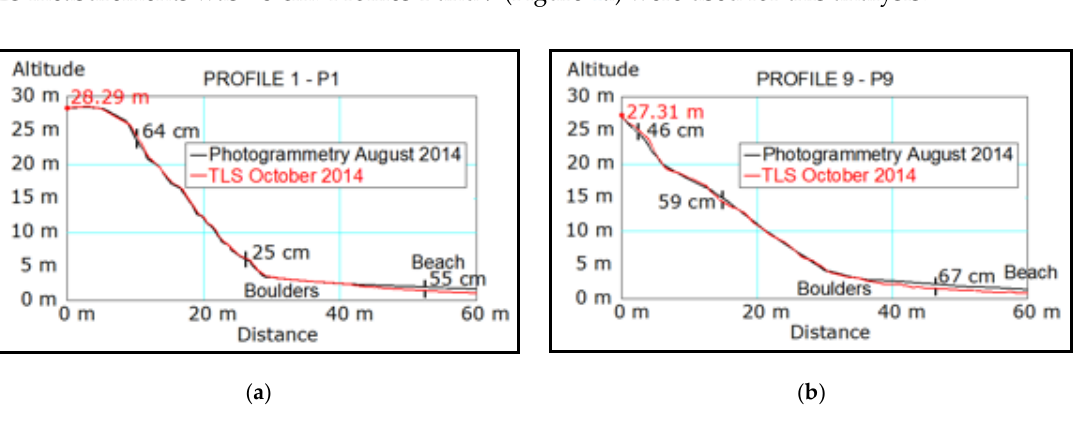
Figure 10. Comparison between the profiles obtained by photogrammetry and by TLS (2014). ( a ) Profile 1 (north area of the cliff); ( b ) Profile 9 (south area of the cliff).